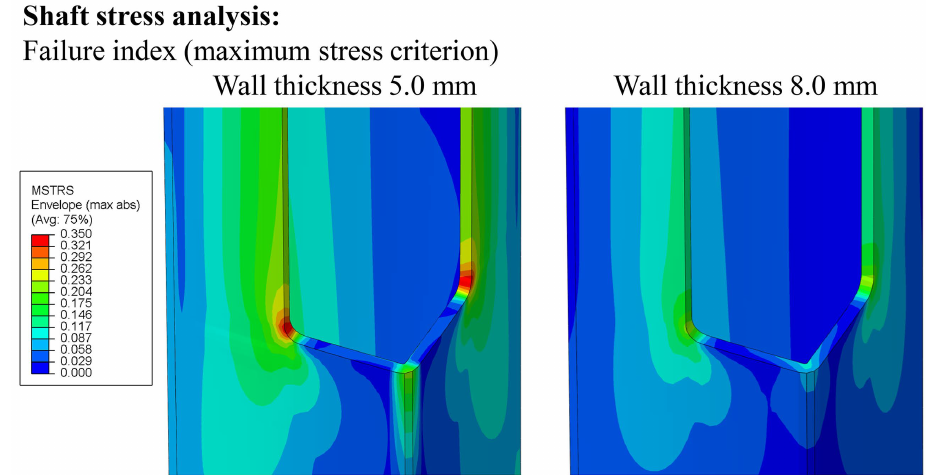
Figure 10. FEA for the failure index when comparing two different pole shaft laminates and a diamond-shaped cross-section (5 mm and 8 mm-wall thickness); corners (hotspot) at a root cutout are shown.